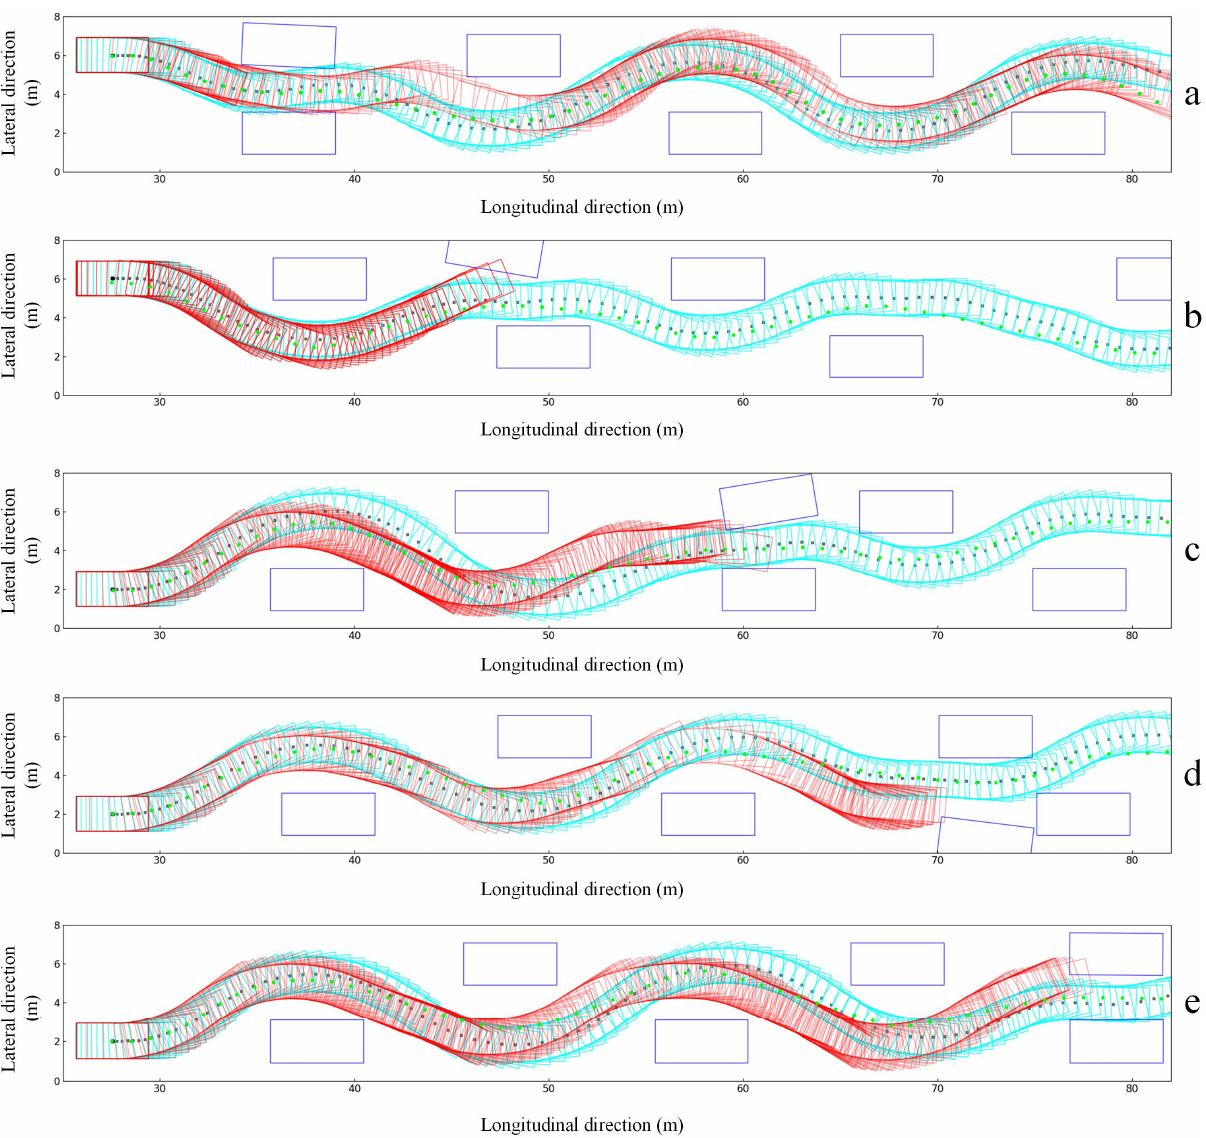
Figure 11. Trajectory comparison of three obstacle avoidance methods ( a – e ).